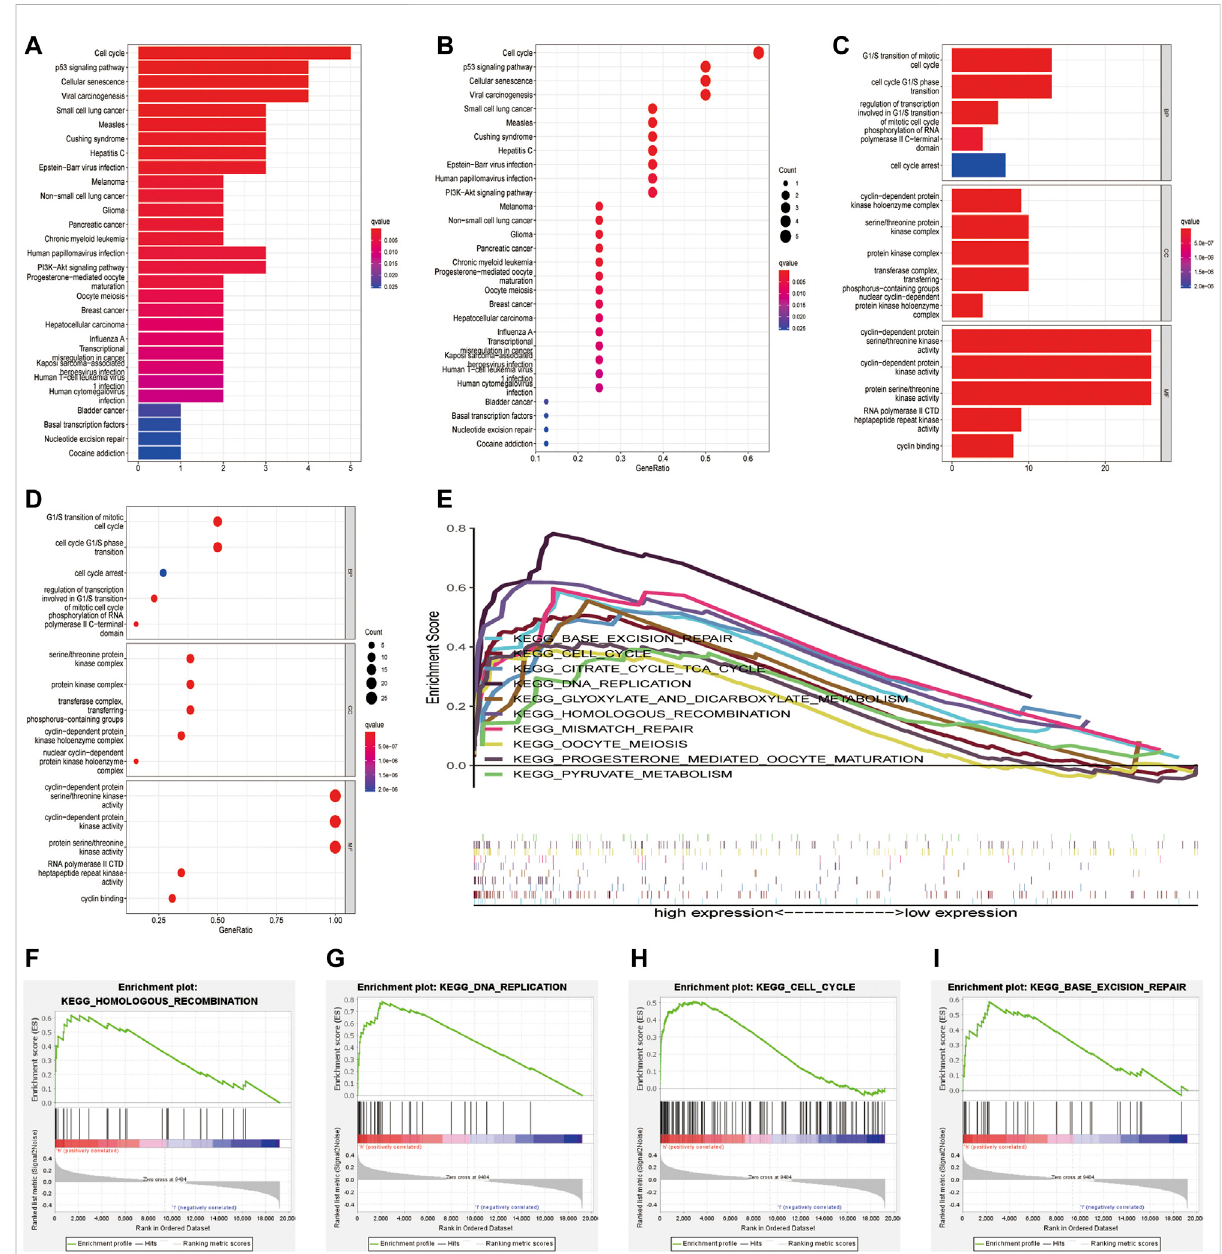
FIGURE 7 Functional enrichment analysis of CDK family genes in endometrial cancer. (A,B) KEGG enrichment analysis of CDK genes. (C,D) GO functional annotation of CDK genes. (E – I) Signi fi cant pathways in the high-and low-risk groups were analysed via